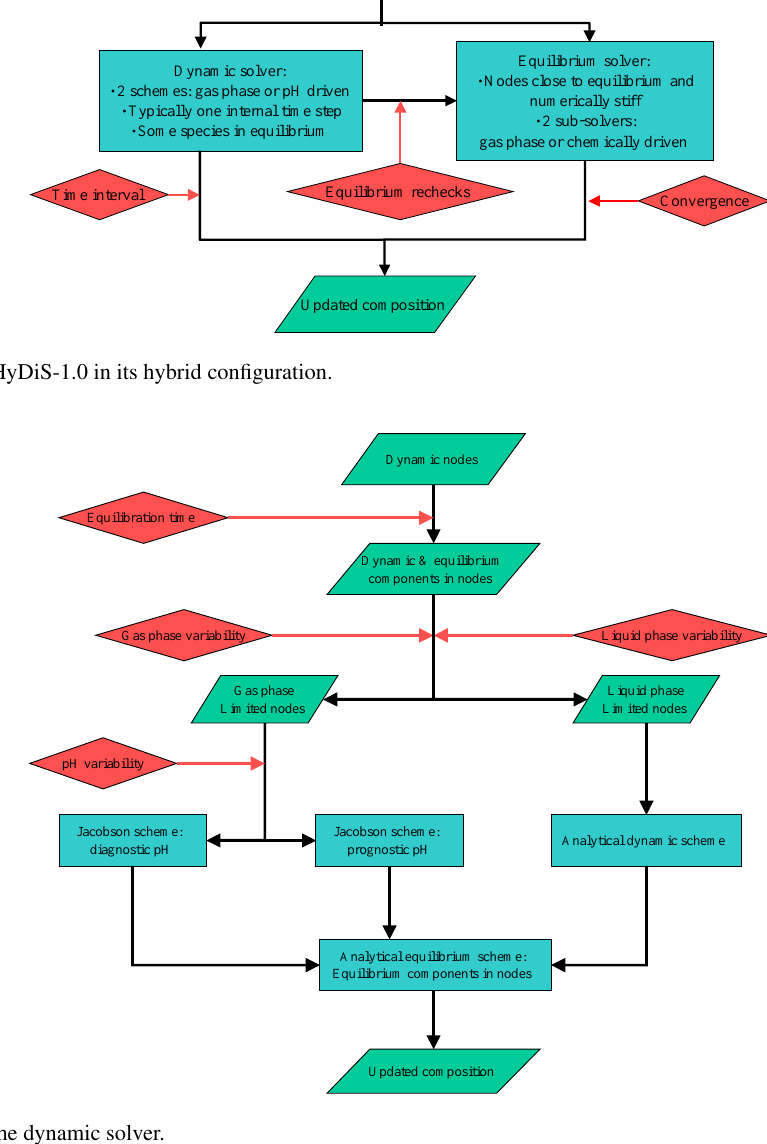
Figure 3. Formalism of the dynamic